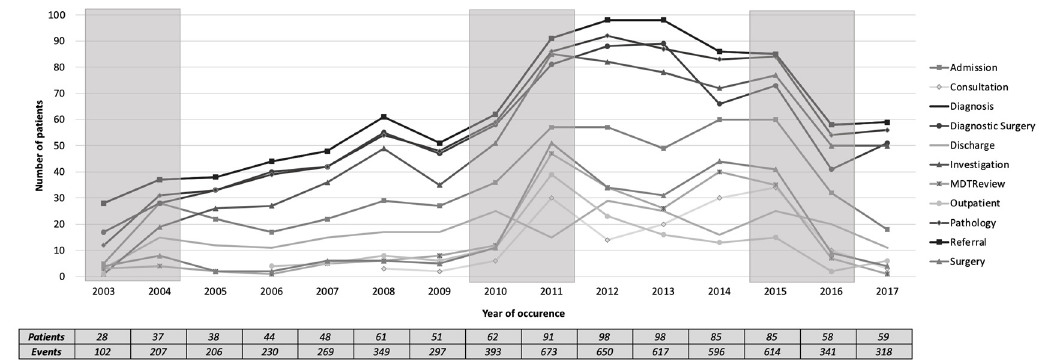
Figure 7. The total number of patients undergoing each of the main activities (2003–2017). The shaded areas show the periods where change might have occurred at the activity level.